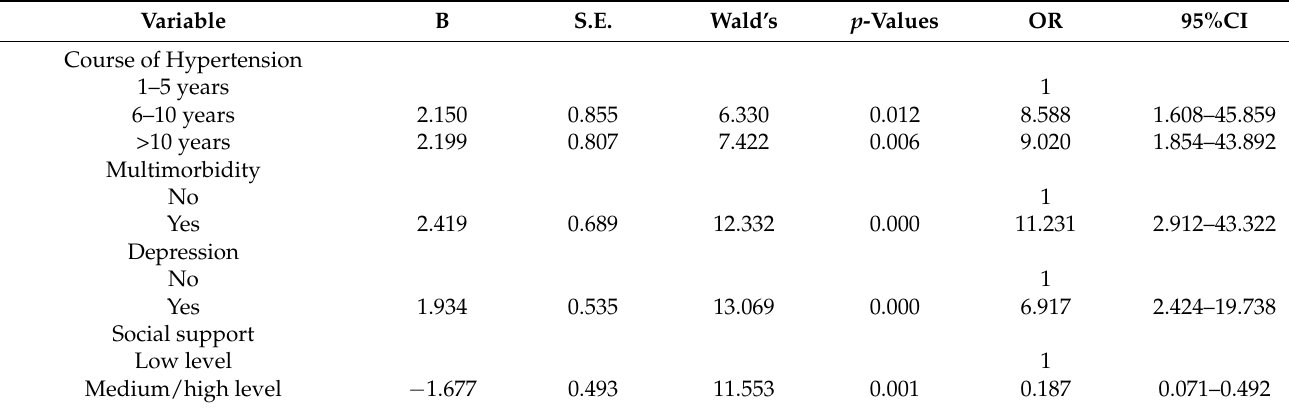
Table 2. Backward selection (likelihood ratio) logistic regression analysis of cognitive frailty in aging patients with